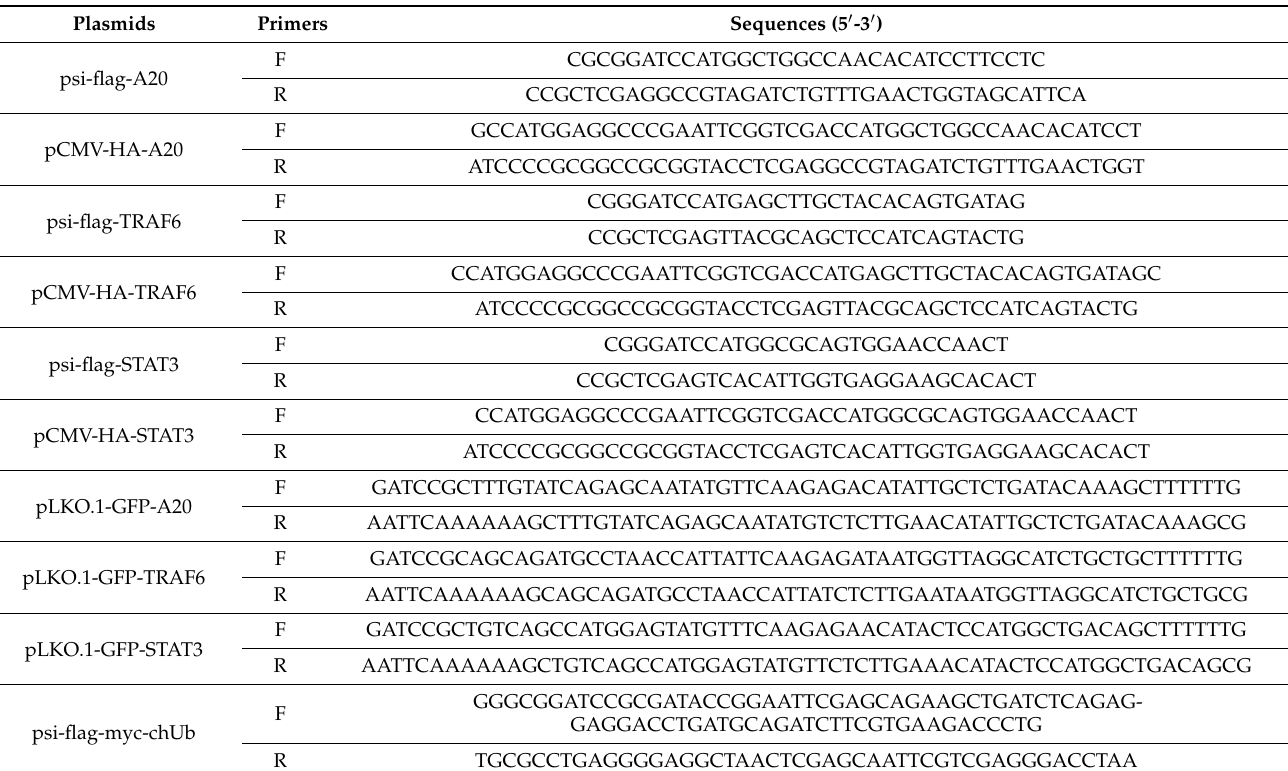
Table 1. Primers for plasmid construction.